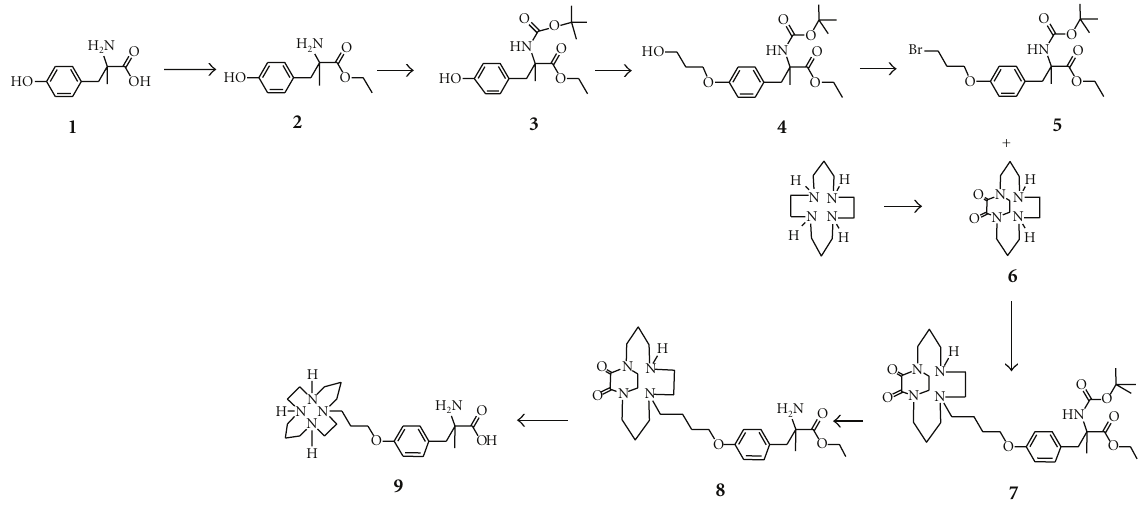
Figure 1: Synthetic scheme of precursor